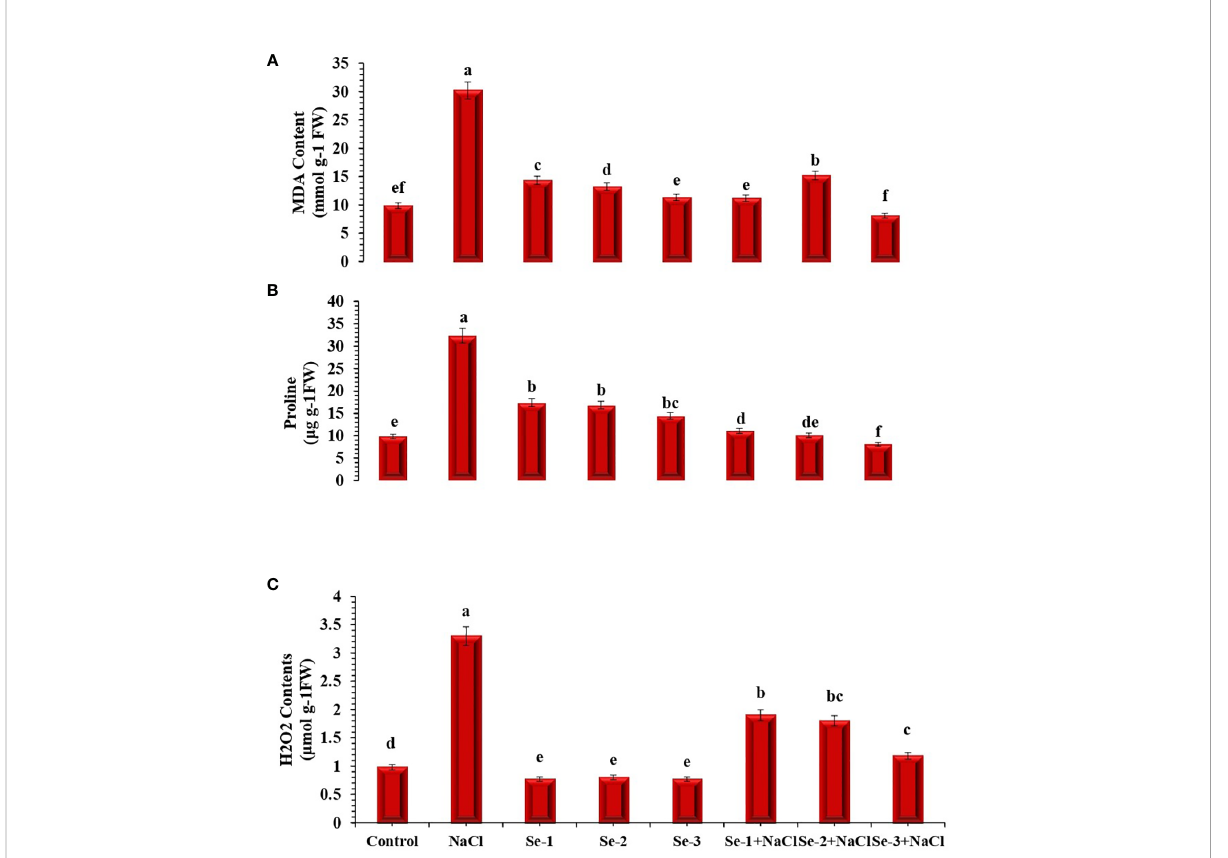
FIGURE 1 In fl uenceof Sepretreatmenton thenon-enzymaticcontentof Brassicarapa seedlingsundersalineconditions. (A) Malondialdehyde(MDA). (B) Proline. (C) Hydrogen peroxide (H 2 O 2 ). Datapresentedarethe mean±SD of fi vereplications. Differentletters denotesigni fi cantdifferences betweentreatmentsat p ≤ 0.05. C , control. NaCl =200mM NaCl; Se-1 =75 m moL − 1 Se; Se-2 =100 m moL − 1 Se; Se-3 =125 m moL − 1 Se.